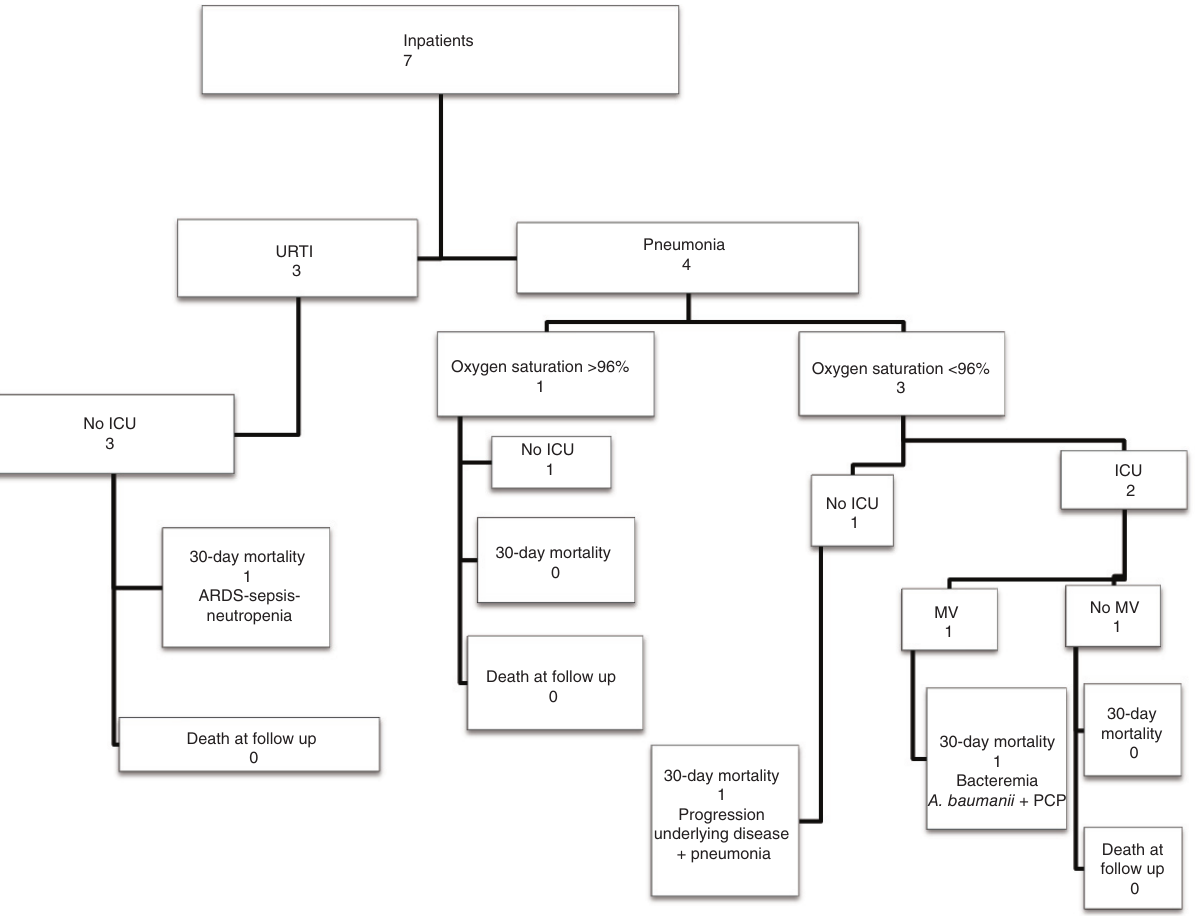
Figure 2. Outcome of immunocompromised patients with nosocomially-acquired pandemic Influenza A H1N1 infection. URTI: upper respiratory tract infection; ICU: Intensive care unit; MV: mechanical ventilation; ARDS: Acute respiratory distress syndrome.